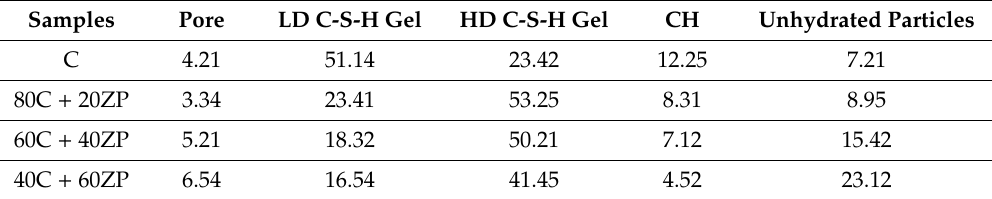
Figure 11. Probability density of elastic modulus of ( a ) C, ( b ) 80C + 20ZP, ( c ) 60C + 40ZP and ( d ) 40C + 60ZP. Table 5. Volume percentages of each phase in the cement matrix (%).